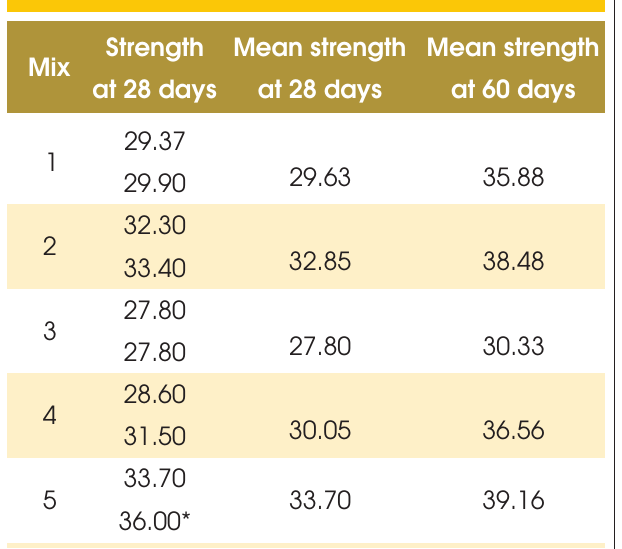
Figure 2 – Variation in the position of specimens exposed to natural environment (Souza,